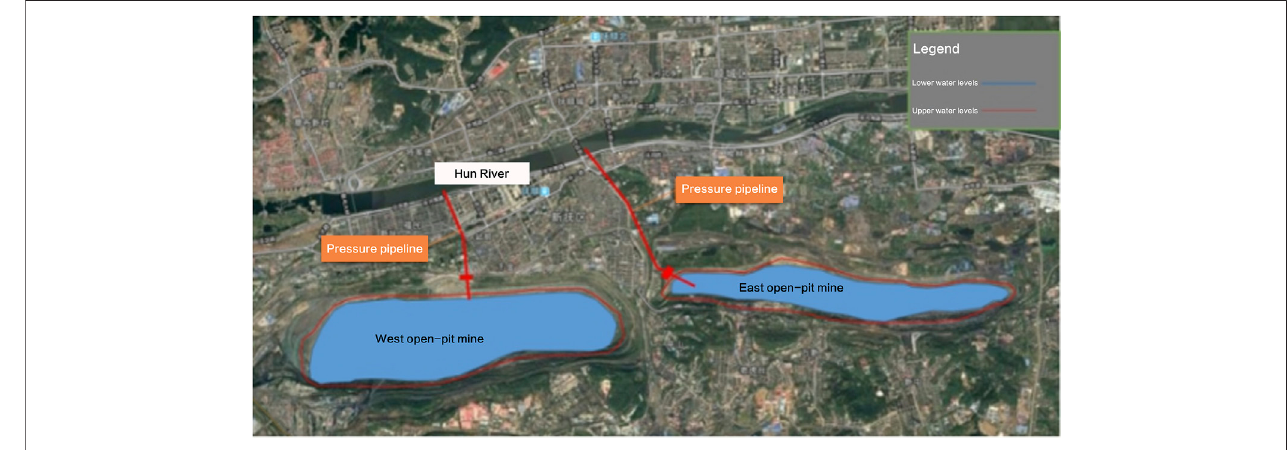
FIGURE 6 | The multi-pit linkage energy storage mode.